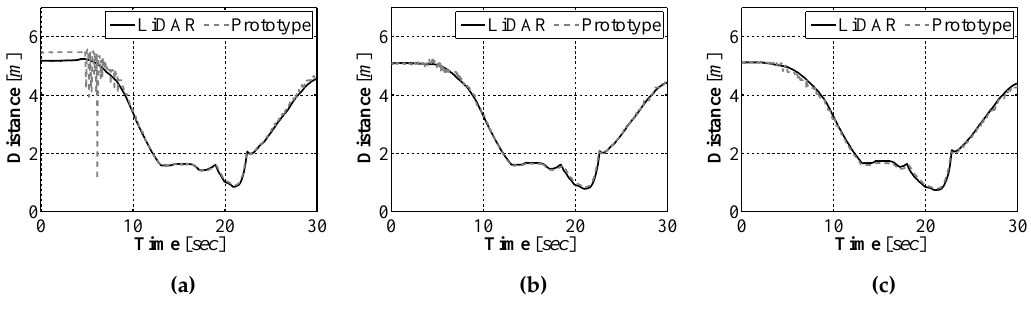
Figure 11. Sensor prototype results vs . LiDAR over time at a relative bearing of and 8 ◦ ( c ).